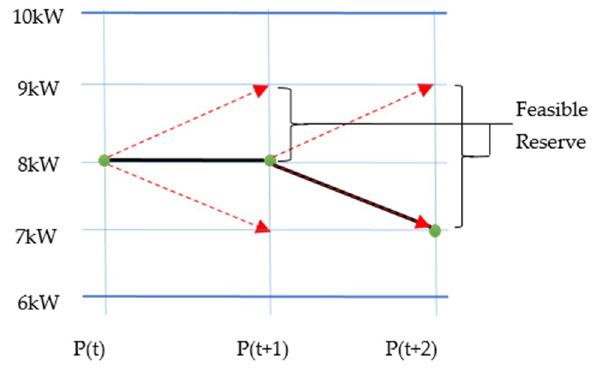
Figure 1. Feasible reserve capability of generators due to ramping up and down. 115